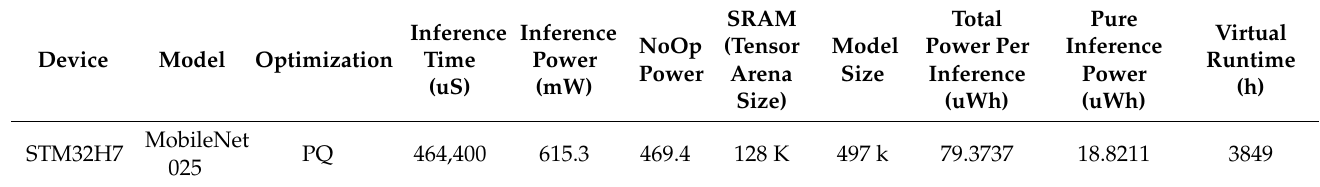
Table 3. MobileNet-025 Model Results.